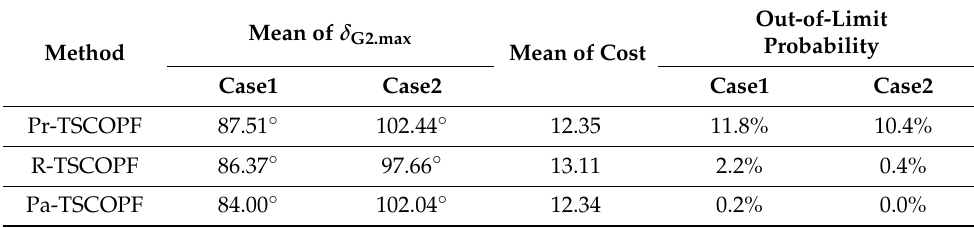
Table 2. Comparison of optimization results of different methods in 3-machine, 9-bus system case. Out-of-Limit Mean of δ G2.max Probability Method Mean of Cost Case1 Case2 Case1 Case2 Pr-TSCOPF 87.51 ◦ 102.44 ◦ R-TSCOPF 86.37